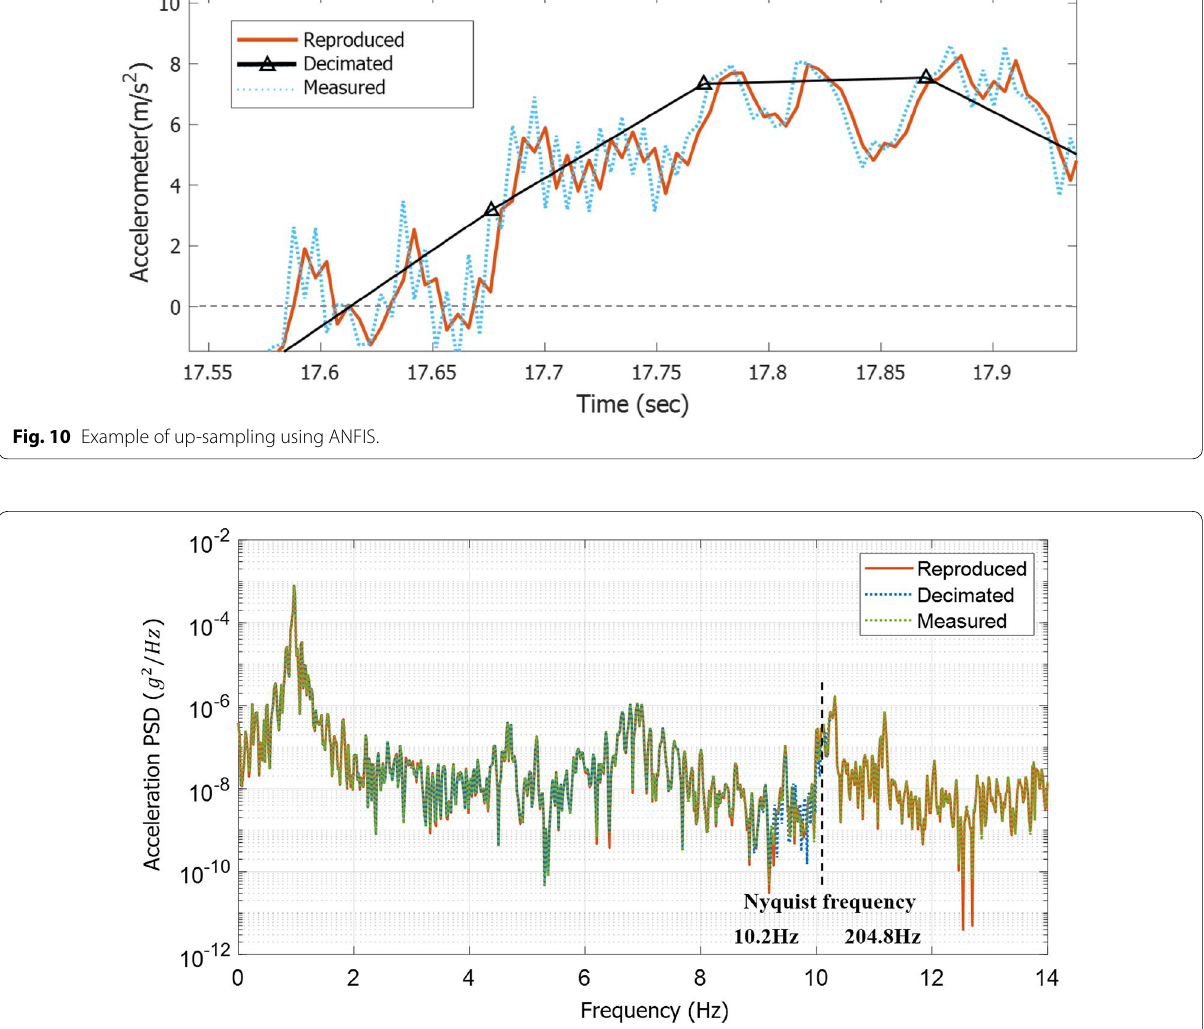
Fig. 11 PSD’s of decimated, reproduced, and measured